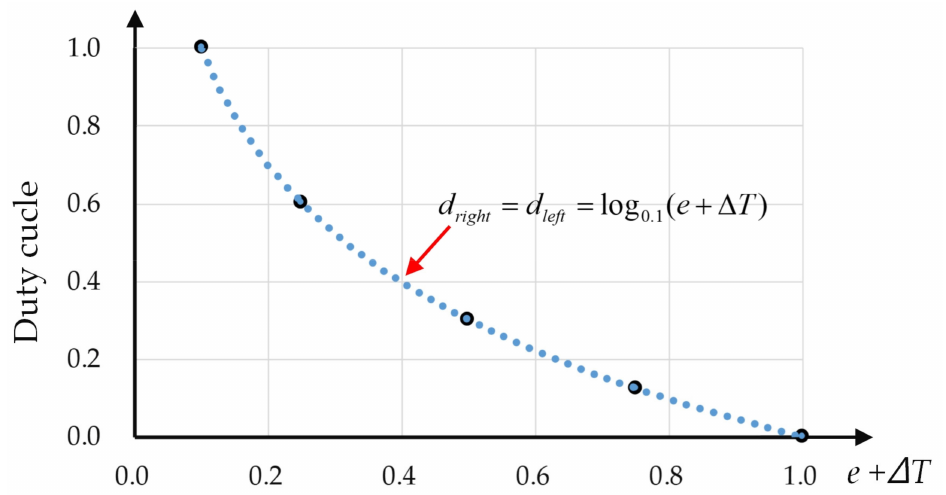
Figure 7. Log 0.1 curve depicting the relationship between the duty cycle and parameter e + operation time ∆ T .